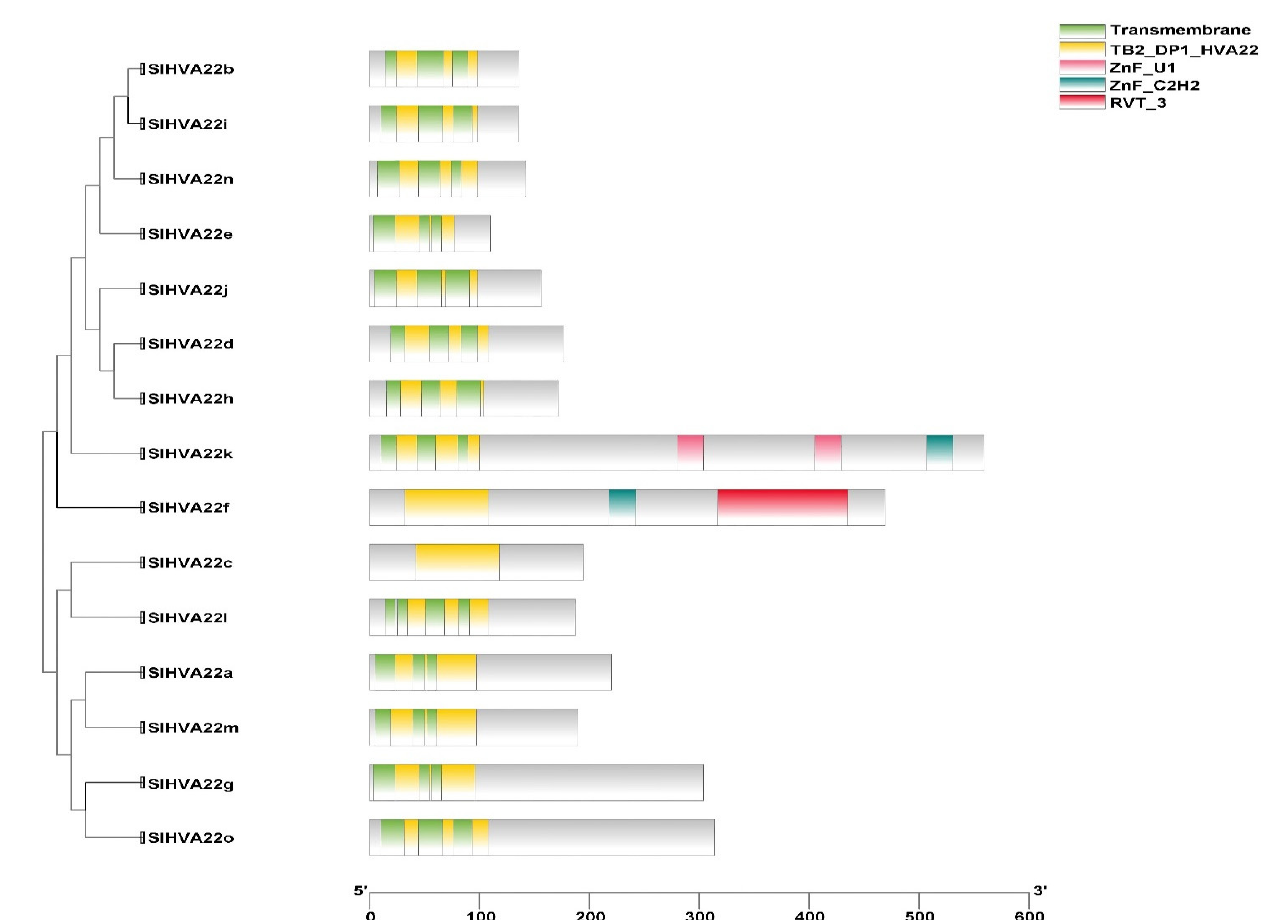
Figure 2. Schematic depiction of the domain organization of SlHVA22 proteins. The transmembrane domain, TB2/DP1/HVA22 domain, U1-type zinc finger (ZnF_U1) domain, the classical C2H2 zinc finger (ZnF_C2H2) domain, and the RVT_3 domain identified in SlHVA22 proteins are shown.